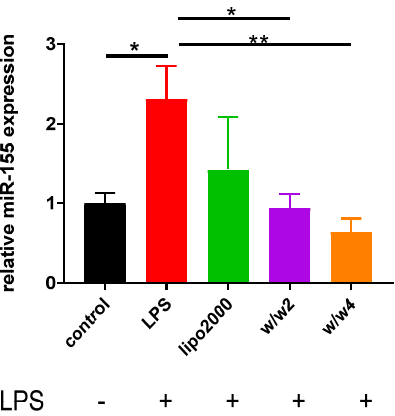
Figure 5. Silencing of miR-155 expression by Chol-PCX/anti-miR-155 in activated macrophages. Chol-PCX/anti-miR-155 prepared at w/w 2 and 4. Lipofectamine 2000 (lipo2000) was used as the positive control. Data were analyzed by one-way ANOVA followed by Tukey’s comparison test. Data are expressed as mean ± SD ( n = 3). * p < 0.05, ** p < 0.01.